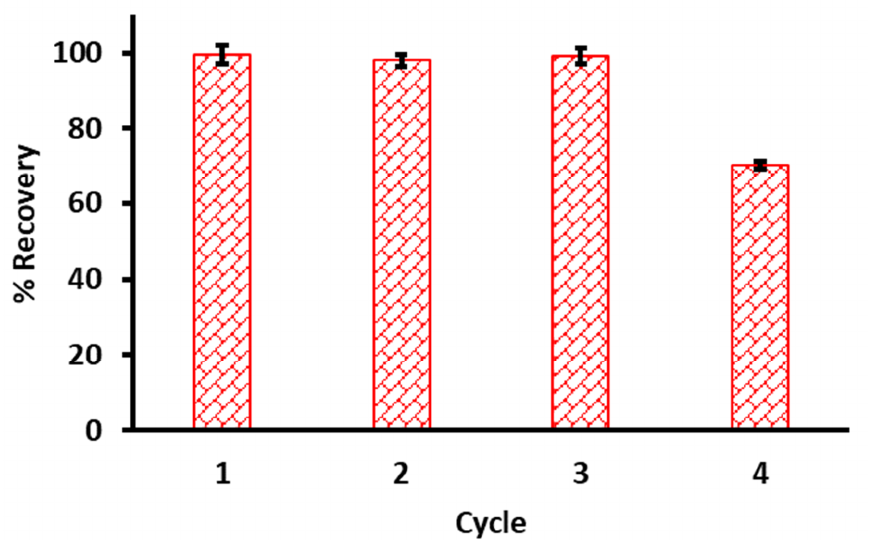
Figure 9. Trenbolone percent recovery during different cycles of reusing the MIP ( n = Figure 9